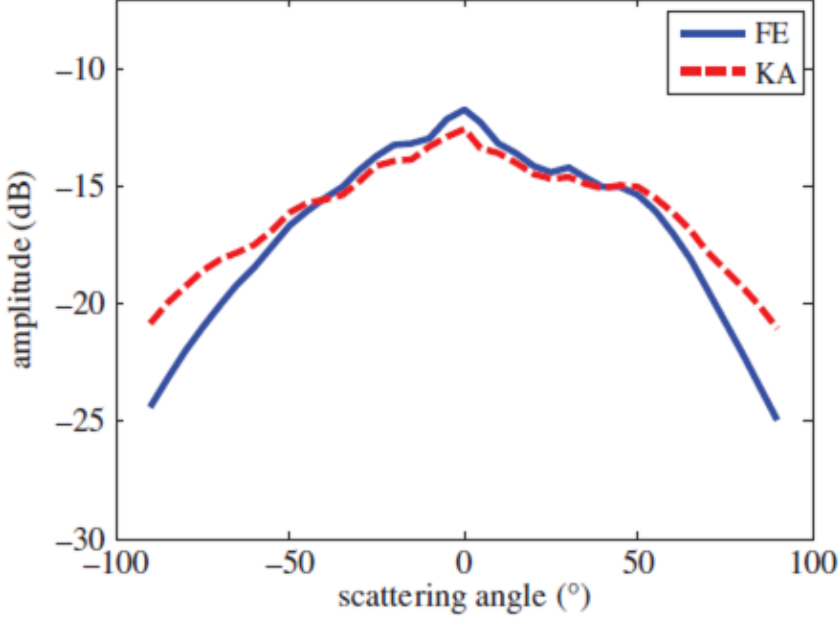
Figure 5. Shi’s Figure 11 [77]. Scattered amplitude versus observation angle using 2D finite element (FE) and Kirchhoff approximation (KA) simulations, for θi = 0°, σ = λ p / 3, L = 0.6 λ p. Reproduced with permission from [77], Royal Society, 2015.